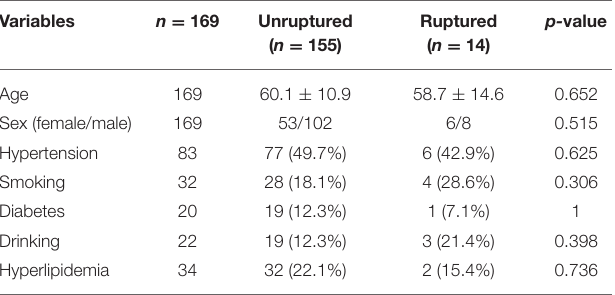
TABLE 1 | Patient characteristics between the unruptured and ruptured aneurysm groups in patients with small intracranial aneurysms. Variables